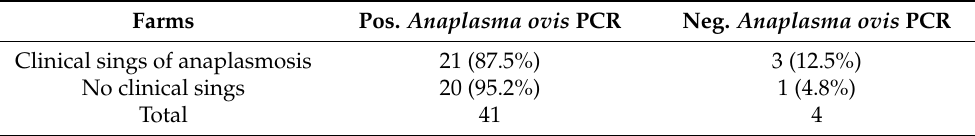
Table 7. Anaplasma ovis detection by PCR in the analysed farms in relation to the presence of clinical signs. Farms Pos. Anaplasma ovis PCR Neg. Anaplasma ovis PCR Clinical sings of